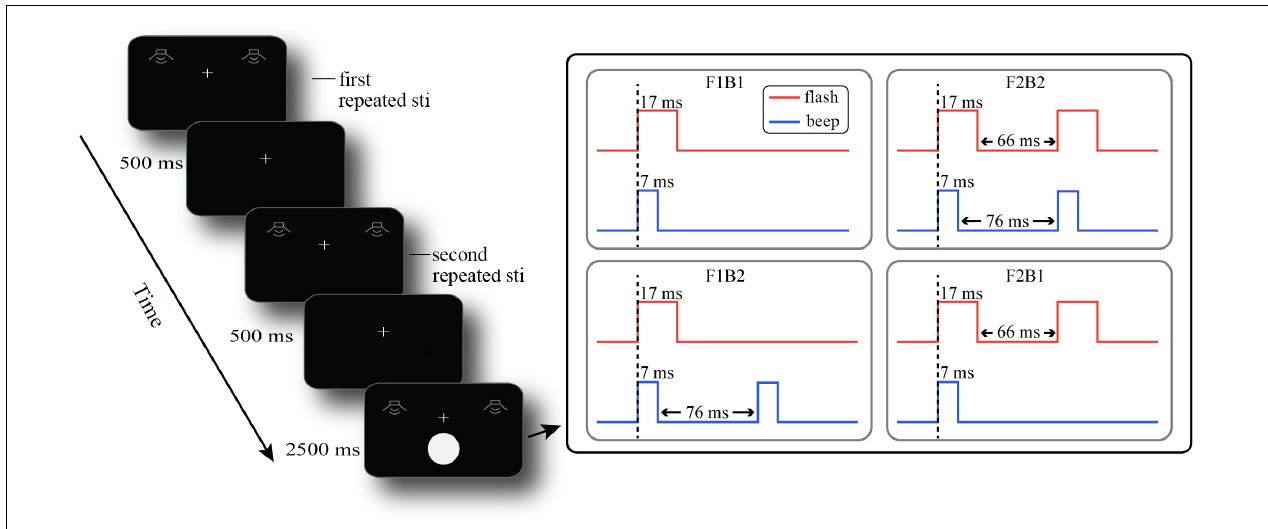
FIGURE 1 | Procedure of events in a sample trial. F1B1 means a visual stimulus accompanied by an auditory stimulus; F1B2 means a visual stimulus accompanied by two auditory stimuli; F2B1 means two visual stimuli accompanied by an auditory stimulus; F2B2 means two auditory stimuli and two visual